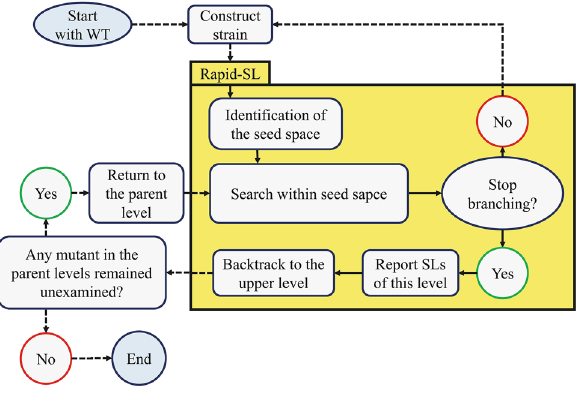
Figure 1. The flowchart of Rapid-SL. Calling Rapid-SL from itself represents the recursive feature of our